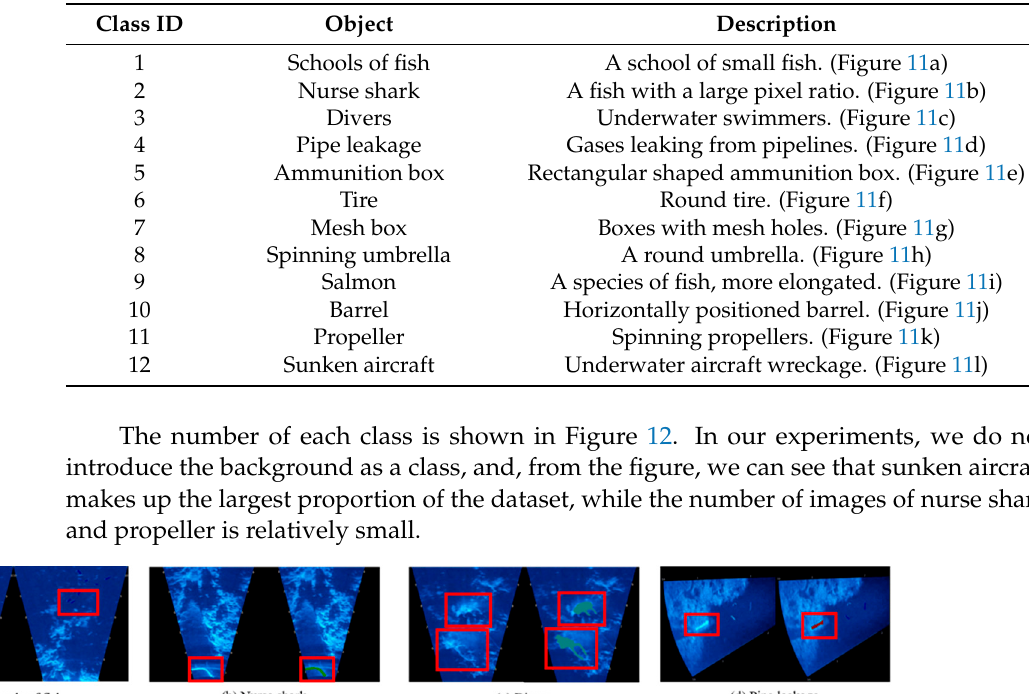
Figure 11. Images of each class and their labeled information images. The red box in each subfig- ure indicates the location of the objects in that class, and different colors are used to show the dif- ferent classes, as shown in subfigures ( a – l ).